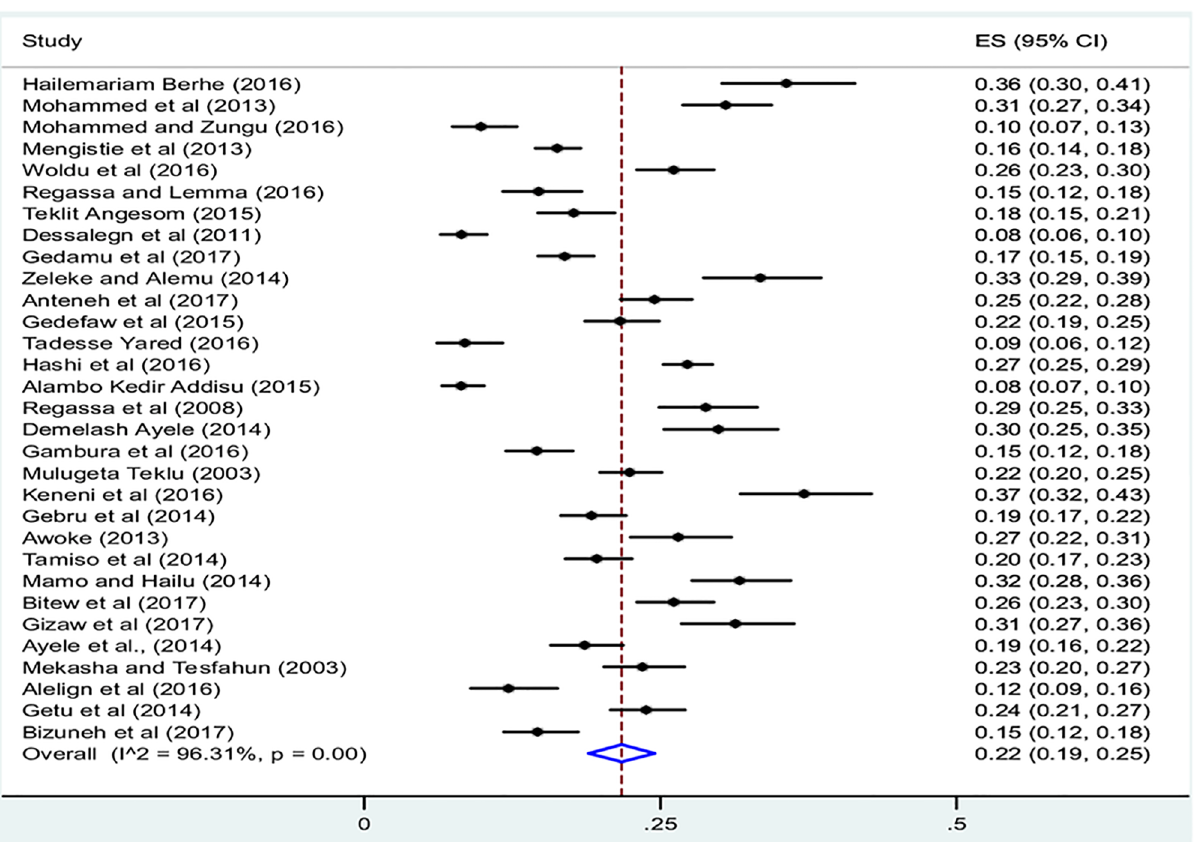
Fig 2. Forest plot of the pooled prevalence of diarrhea among under-five children in Ethiopia.